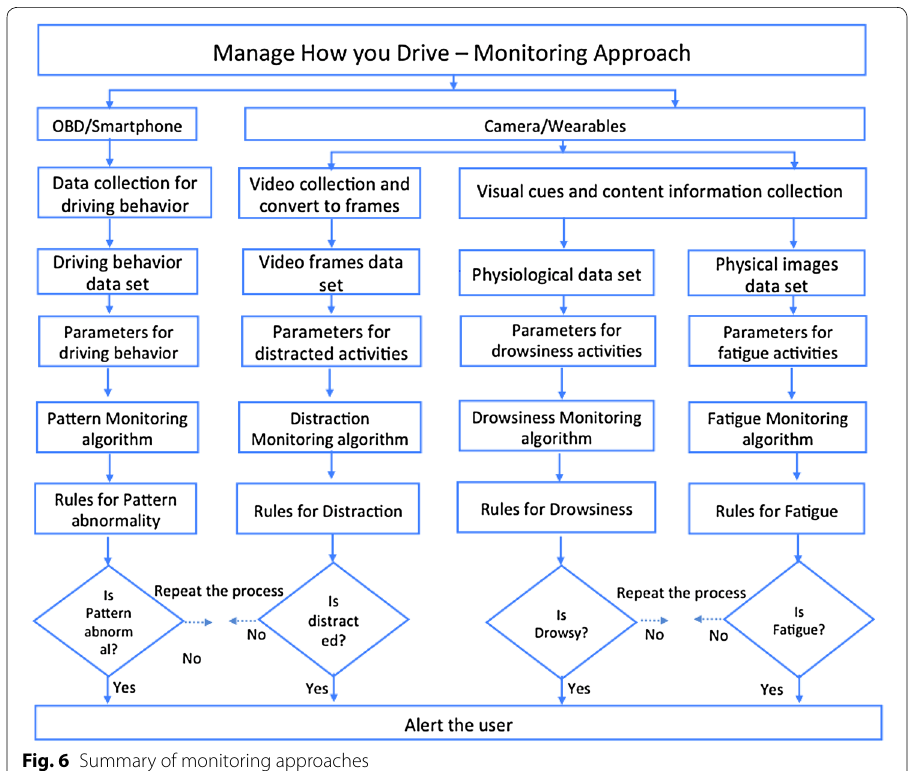
Fig. 6 Summary of monitoring